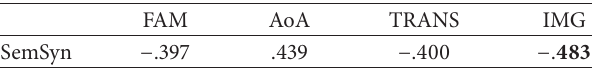
Table 4: Results of the classification procedures (rounded percent-